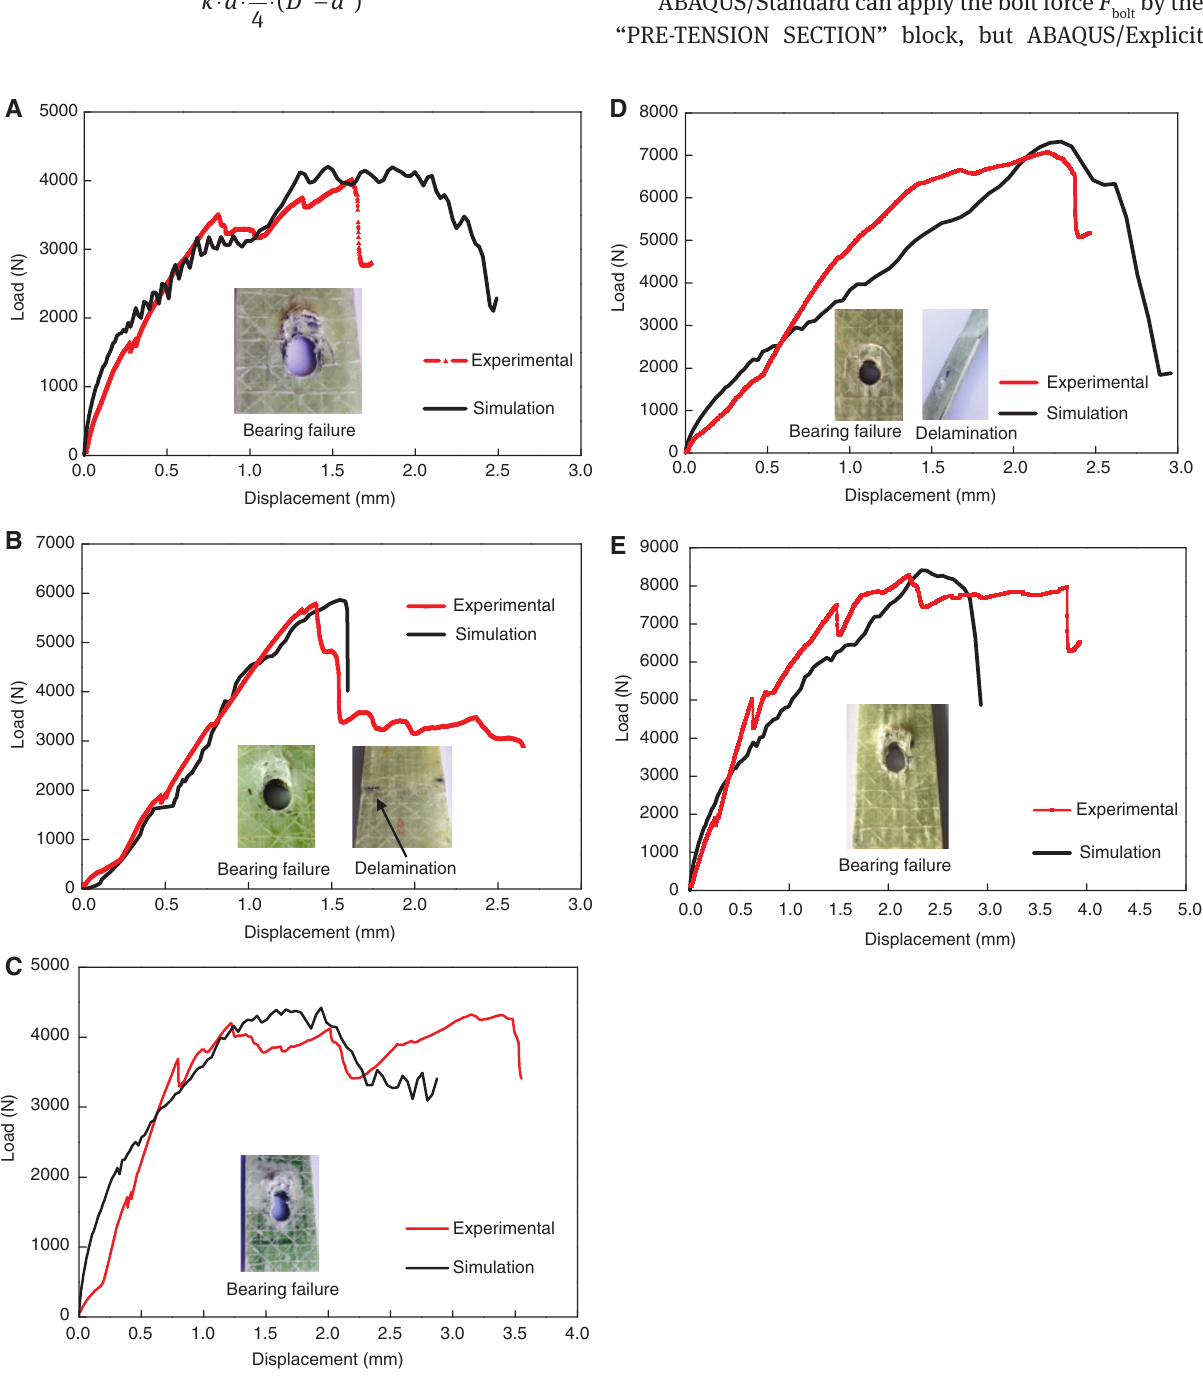
Figure 10: Comparisons of load-displacement curves between simulation and experimental results. (A) Specimen A, (B) specimen B, (C) specimen C, (D) specimen D and (E) specimen